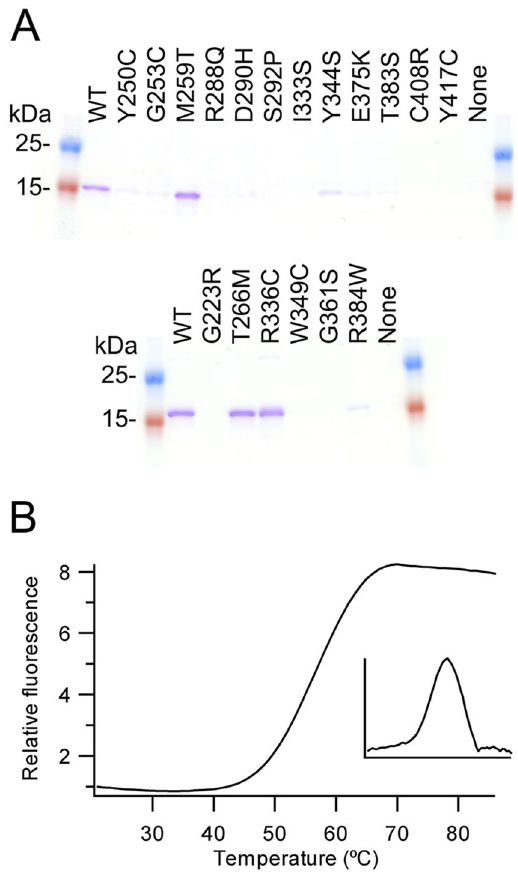
Figure 5. Analysis of loss of function mutations ( A ) Coomassie stained SDS-PAGE gel of IMAC purified proteins. Upper gel Angptl3, lower gel Angptl4 (Supplementary Fig. 1 shows the full gels) ( B ) Thermal stability of purified wild-type Angptl3 determined by thermofluor. The insert panel shows the derivative of the change in fluorescence signal. Angptl3 shows cooperative